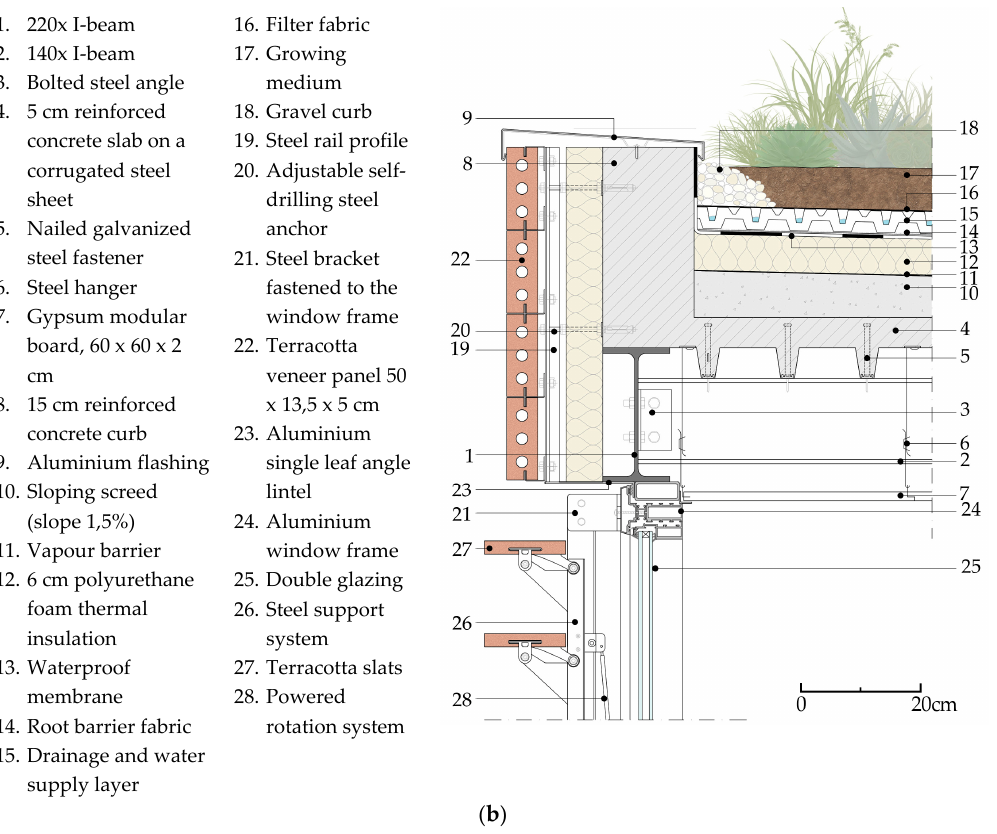
Figure 8. ( a ) Render of the new connection element between the convent and the church. ( b ) Construction detail of the new element.